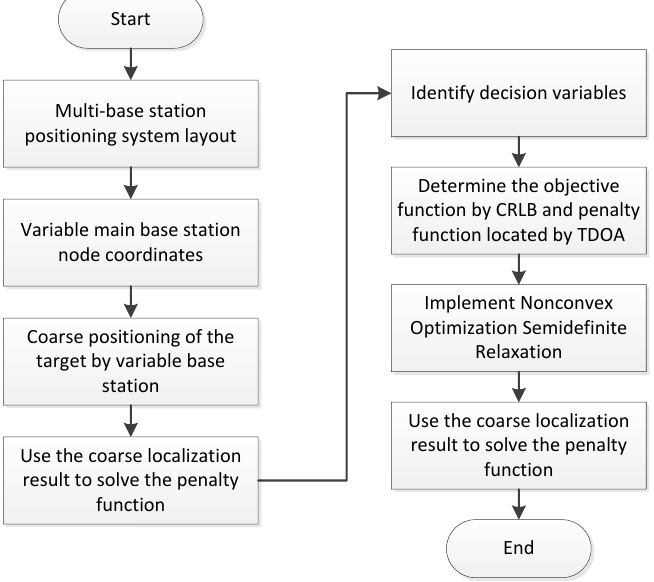
Figure 2. Flow chart of optimization algorithm for node selection.